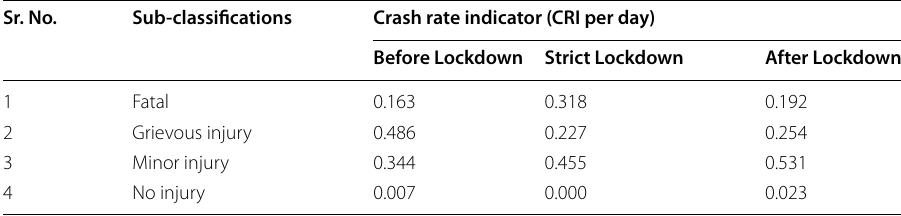
Table 4 CRI by classification of crash Sr.